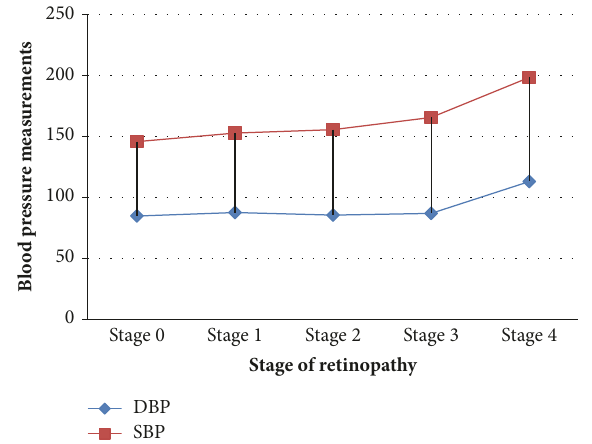
Figure 1: Mean blood pressure measurement by stage of retinopa-